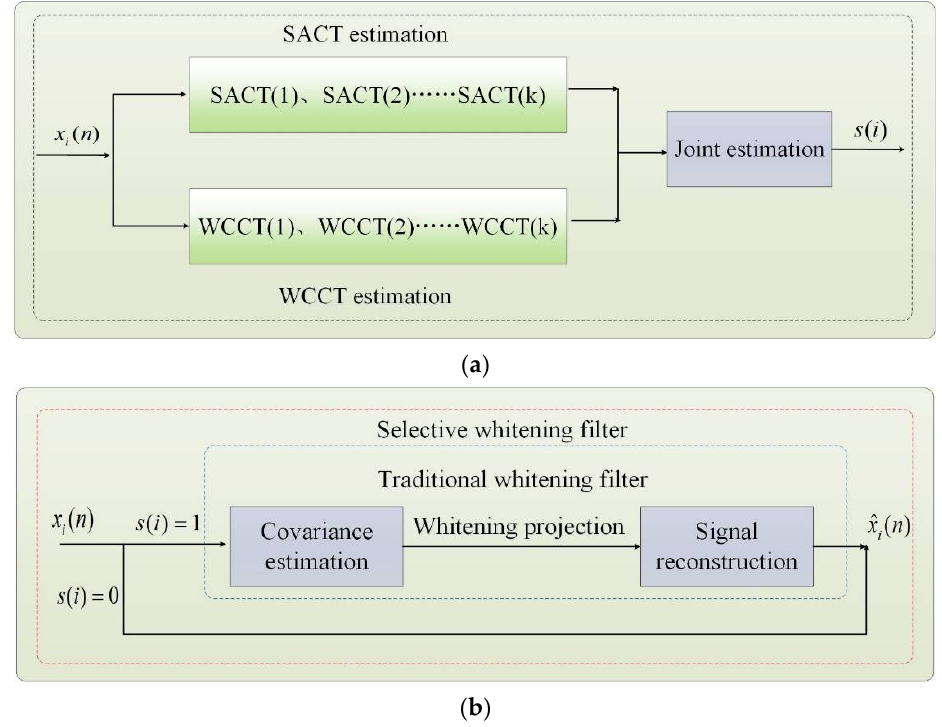
Figure 2. Flow chart of the proposed sea clutter suppression stage. ( a ) Sea clutter suppression method based on correlation time estimation. ( b ) Selective whitening filter.